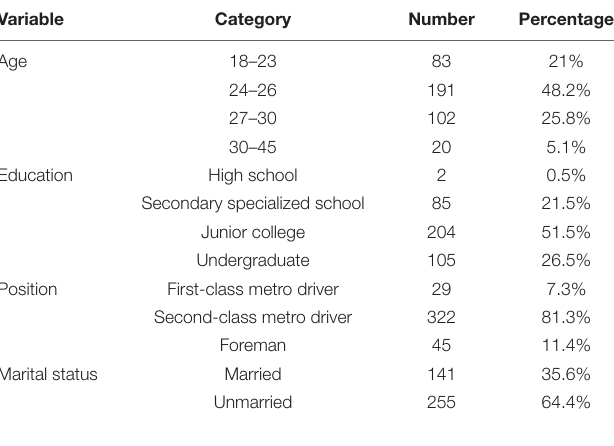
TABLE 1 | Statistical description of